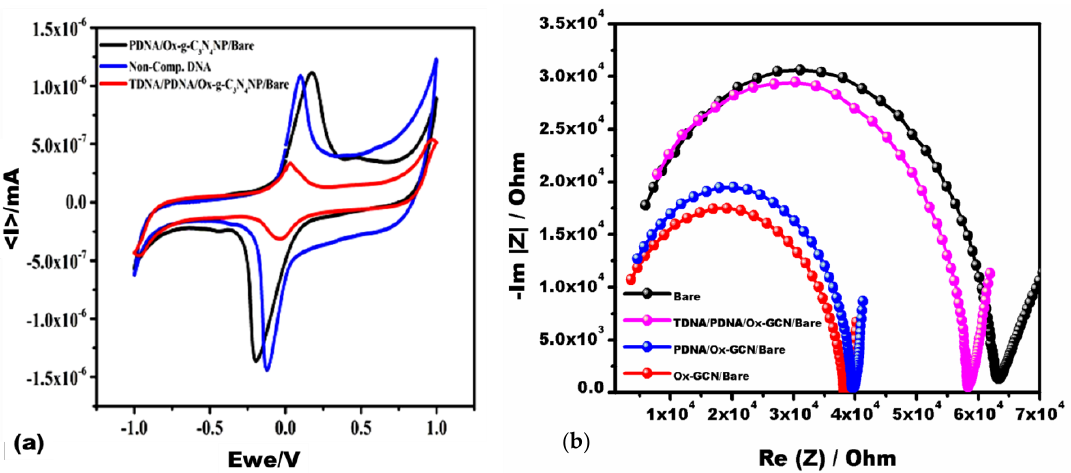
Figure 2. ( a ) CV at various stages including Bare, Ox-g-C 3 N 4 modified, PDNA / Ox-g-C 3 N 4 / ePAD, TDNA / Ox-g-C 3 N 4 / ePAD conducted in 0.1 mM KCl containing 0.1 mM MB (pH 7.2) (Potential 1 mV) at the scan rate of 100 mV / s and ( b ) Nyquist plot at various stages of ePAD including Bare, Ox-g-C 3 N 4 modified, PDNA / Ox-g-C 3 N 4 / ePAD, TDNA / Ox-g-C 3 N 4 / ePAD conducted in '0.1 mM KCl containing 0.1 mM MB (pH 7.2) at the frequency range of 100 Hz–10 3